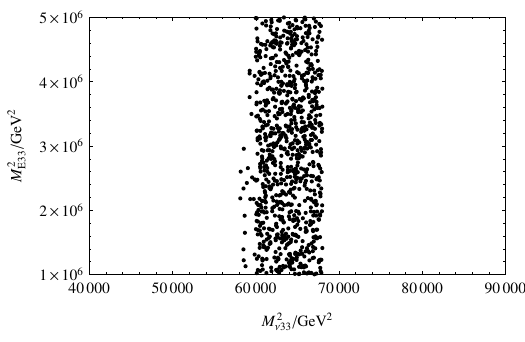
Figure 4 . The allowed results of the relic density in the plane of M 2